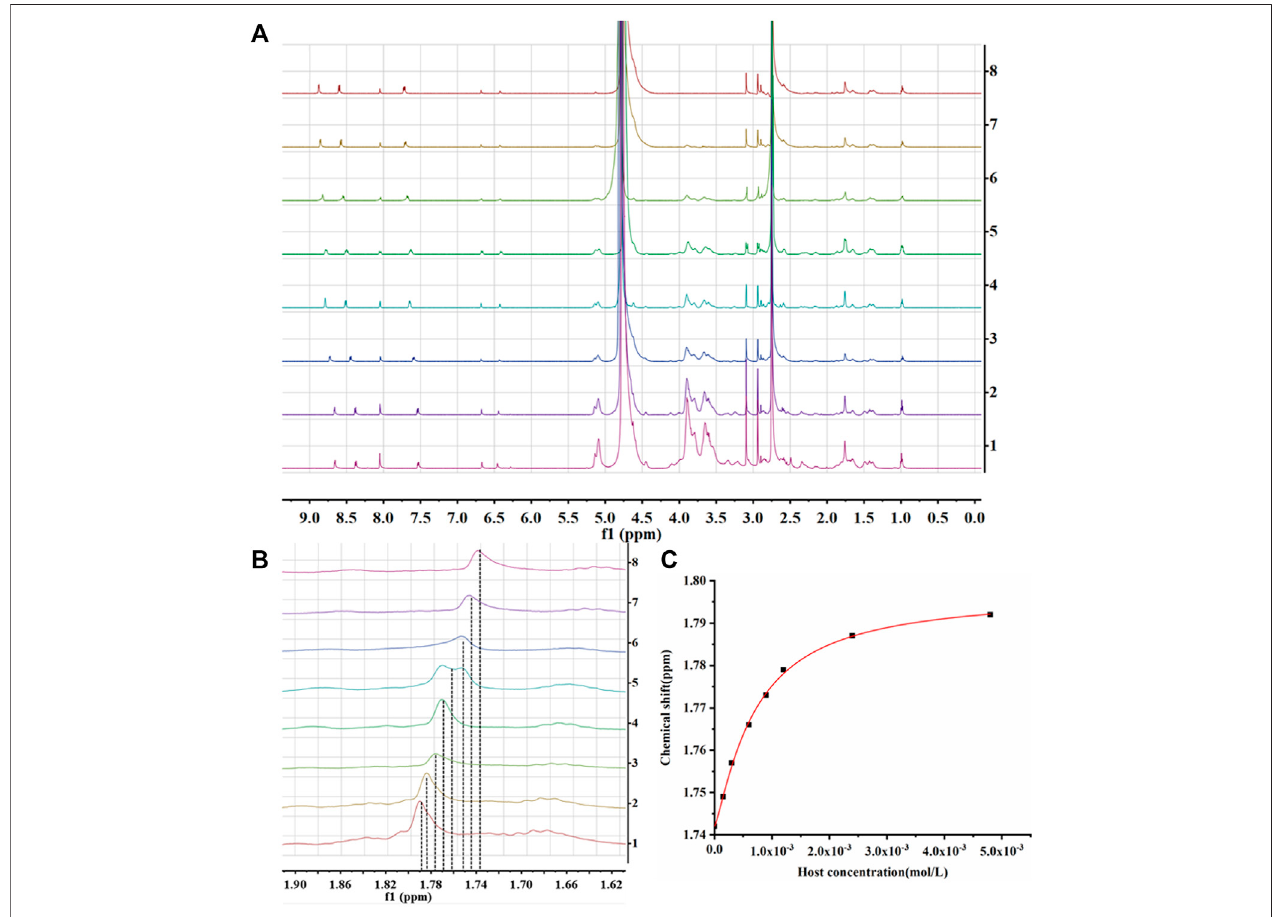
FIGURE 7 | (A) 1 H NMR spectra in D 2 O at 25 ° C (From top to bottom, host: guest was 0 – 1.6); (B) The enlarged view of 1.62 ∼ 1.90 ppm of (A) ; (C) The titration curve of AD-CBD/BIO-CD inclusion complex.